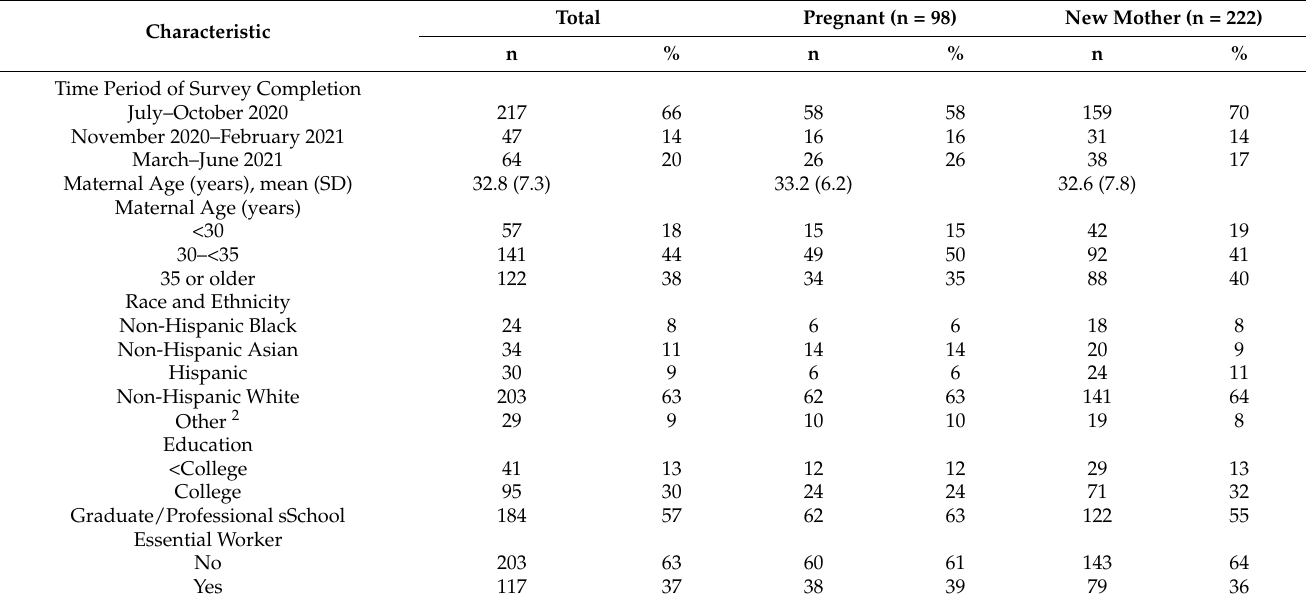
Table 1. Distributions 1 of selected characteristics among women participating in the Maternal Health and Behavior Study (n =